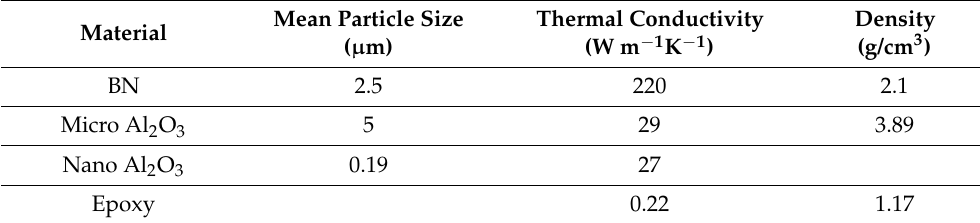
Table 1. Detailed information of the matrix and